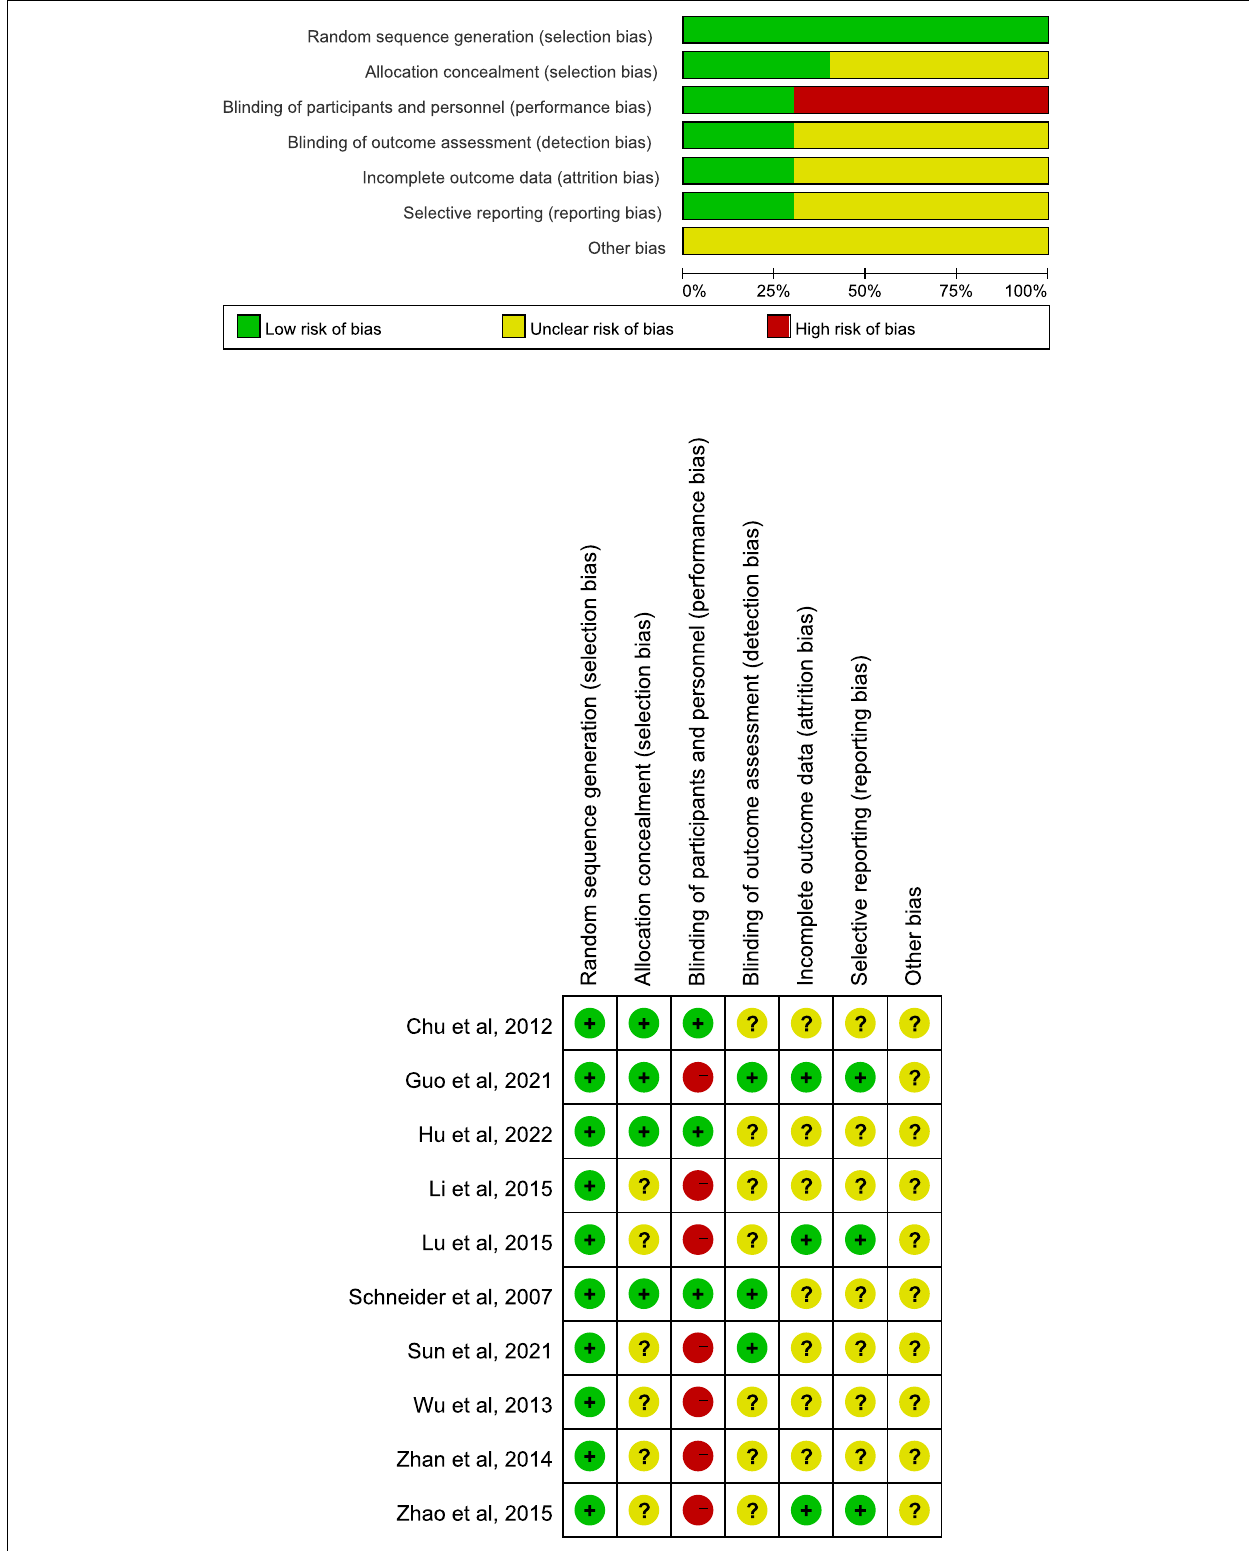
Frontiers in Neuroscience |